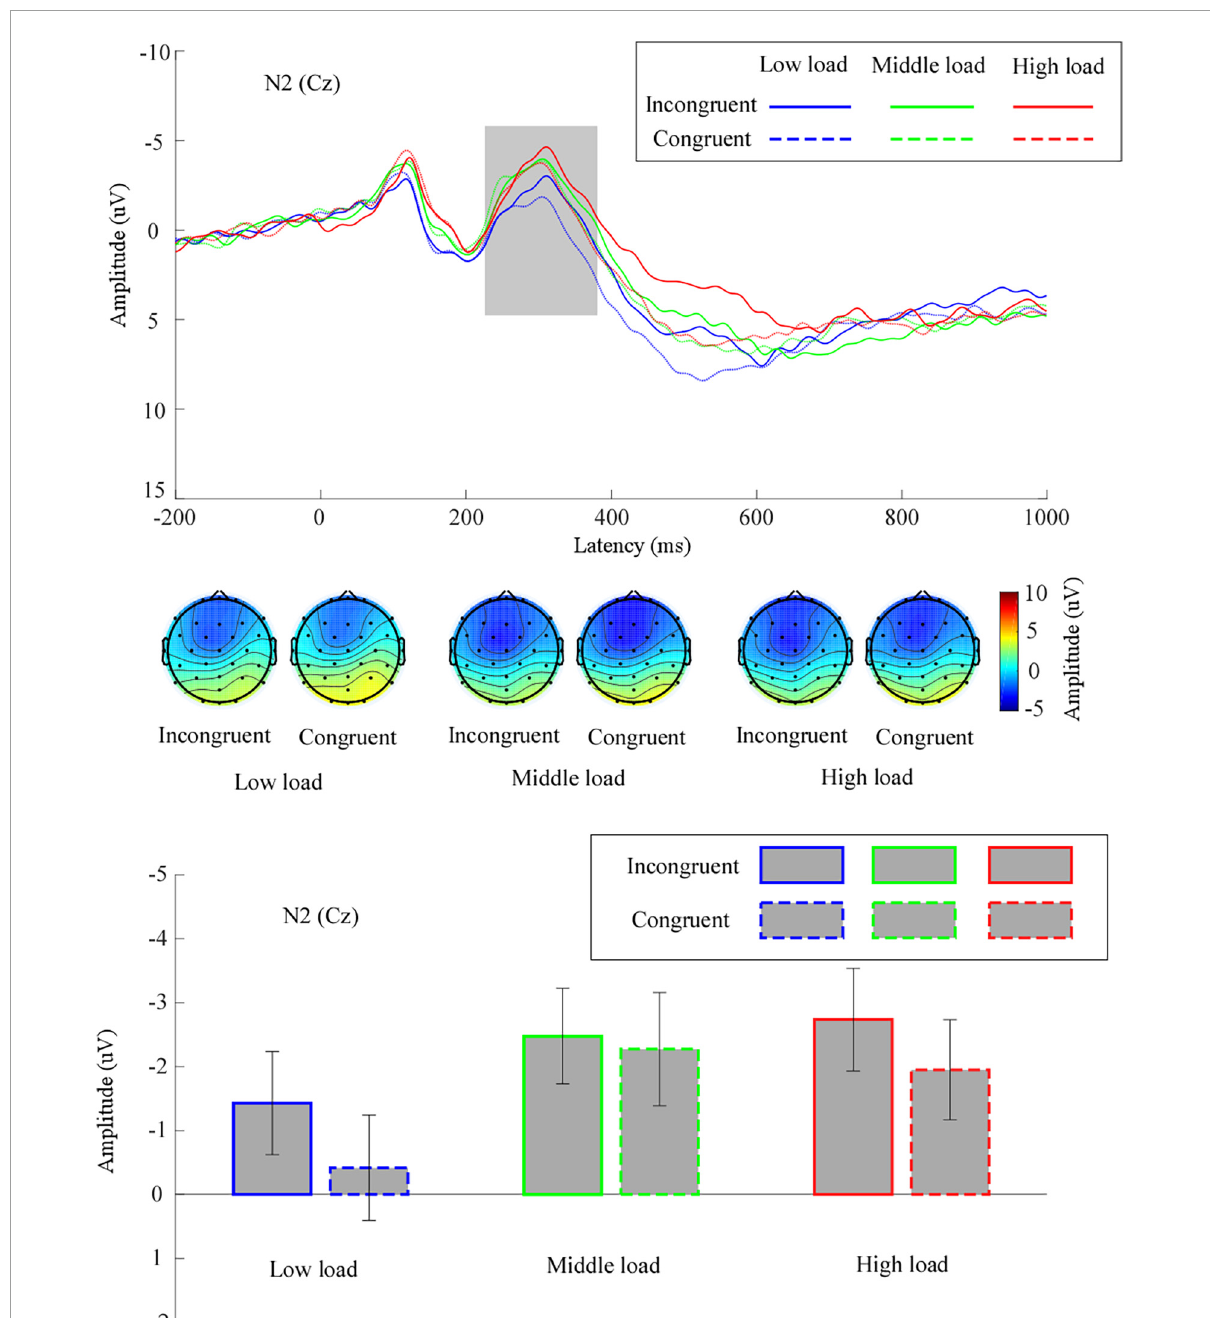
FIGURE3 The grand means of N2’s waveforms across different conditions at electrode site Cz. Additionally, the topography of N2 (time window: 230–380 ms), and mean values for N2 amplitude are given. Low load, low WM load; middle load, middle WM load; high load, high WM load.